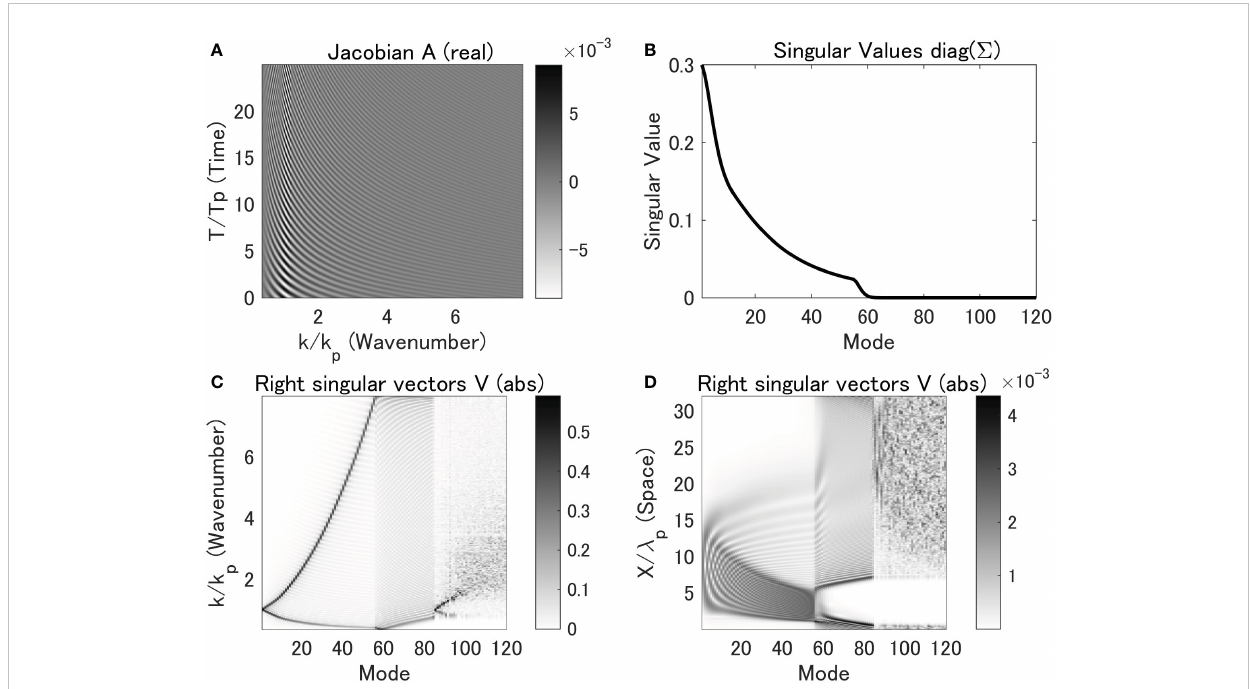
FIGURE 3 Approximated Jacobian obtained from the linear dispersion relation. (A) The real part of the approximated Jacobian A ’ , (B) the singular values of the approximated Jacobian, (C) the absolute values of the right singular vectors of the approximated Jacobian in the wavenumber domain, and (D) the absolute values of the right singular vectors transformed to the spatial